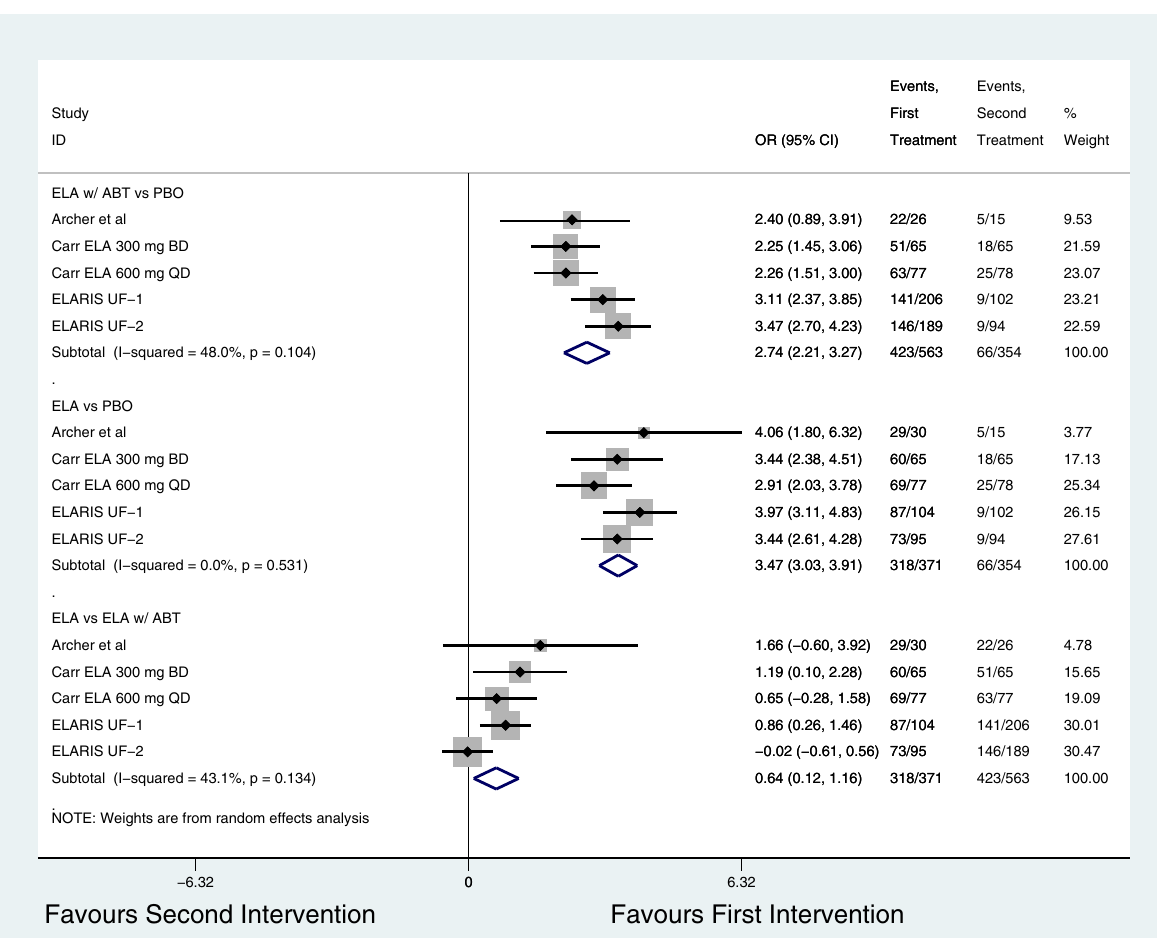
Fig. 2 Forest plot comparing the primary outcome (women with MBV ≤ 80 ml/cycle and ≥ 50% reduction from baseline) across